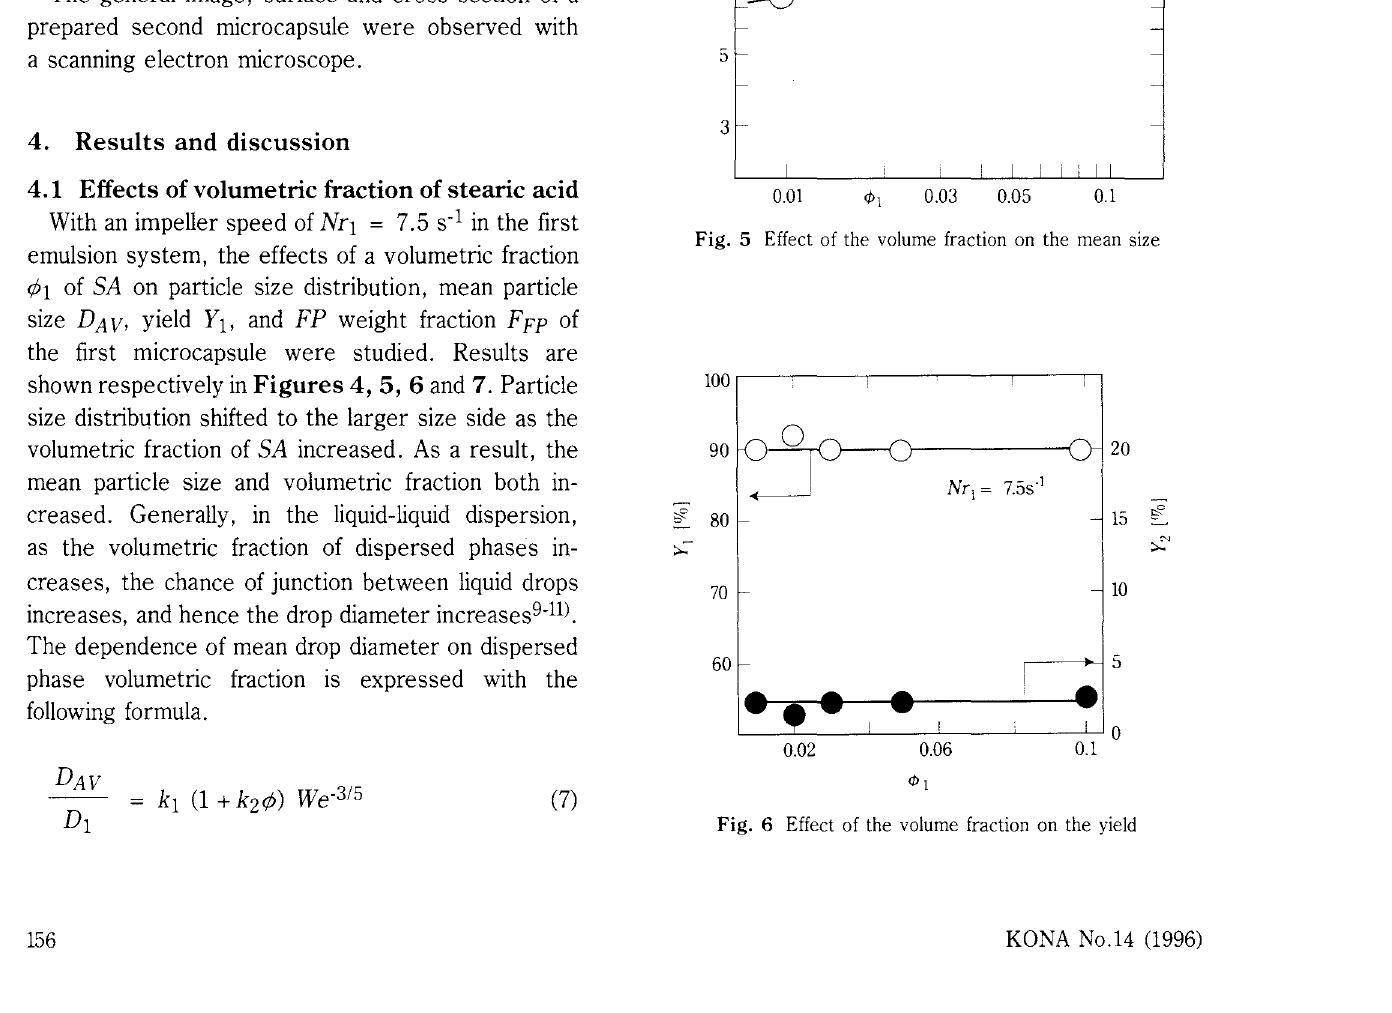
Fig. 4 Effect of the volume fraction on the size distribution